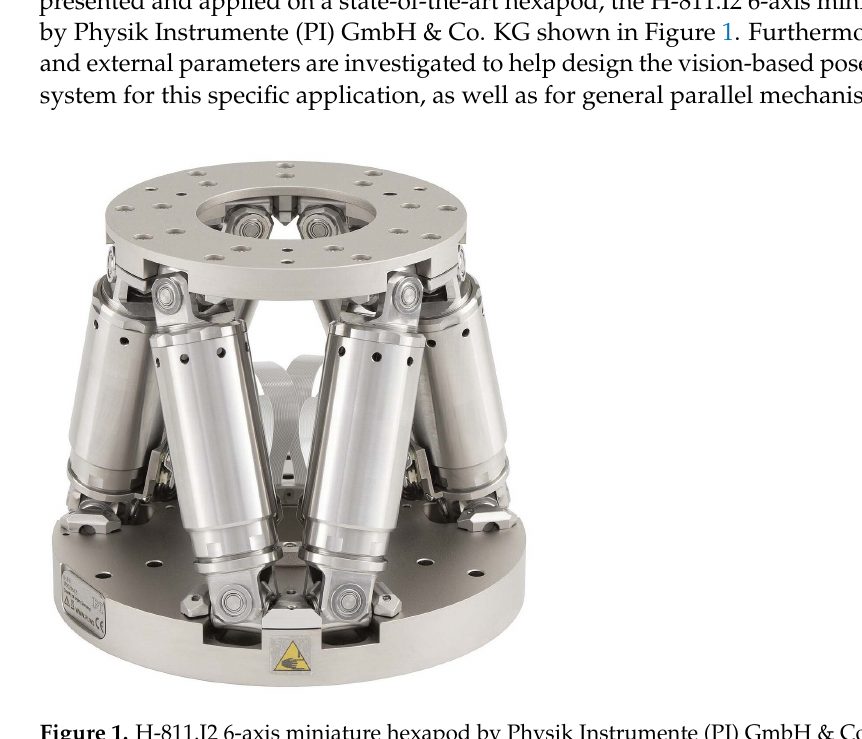
Figure 1. H-811.I2 6-axis miniature hexapod by Physik Instrumente (PI) GmbH & Co. KG. Picture by Physik Instrumente (PI)